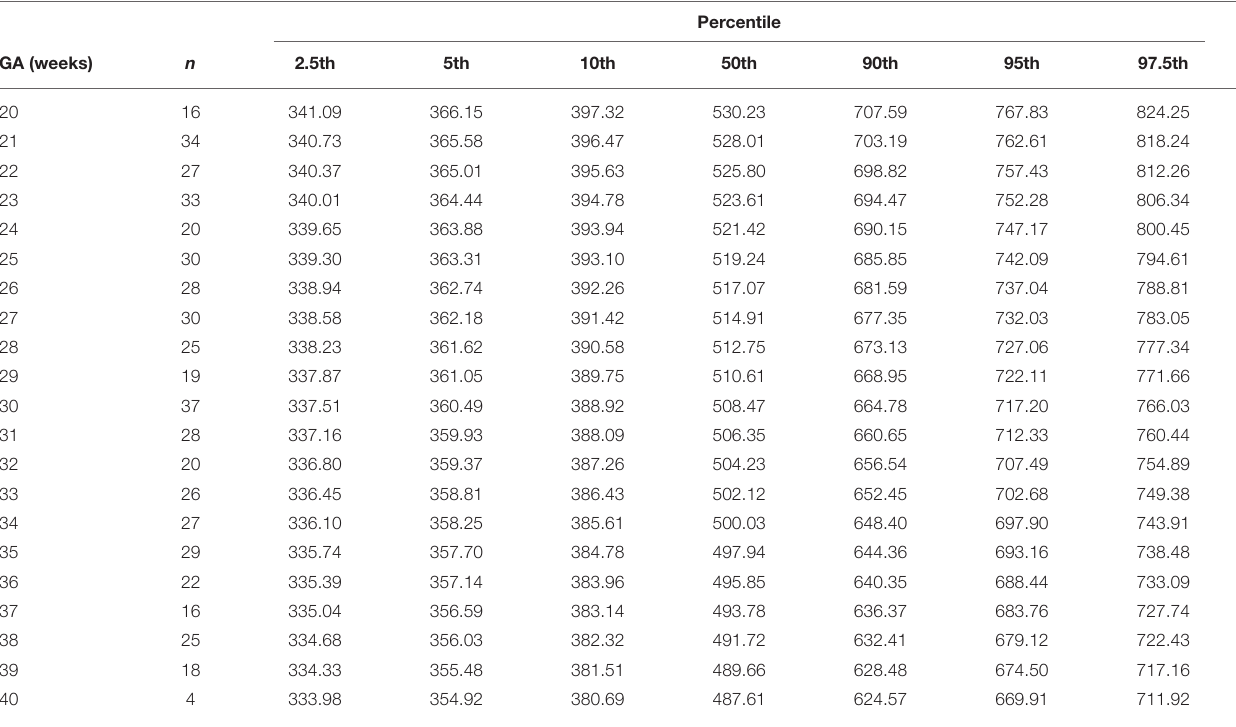
TABLE 10 | Percentiles of normalized (weight-indexed) combined ventricular cardiac output (ml/min/kg) at 20–40 weeks of gestational age.